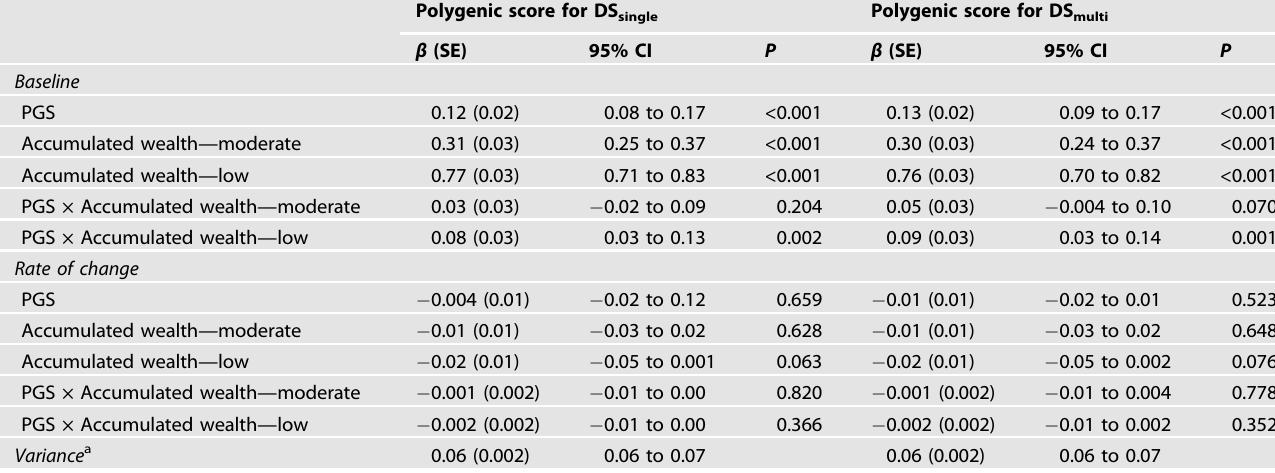
Table 3. Longitudinal mixed models exploring the main effect of polygenic score for DS and accumulated wealth, and interaction between these two variables, in relation to depressive symptoms trajectories during the 14-year follow-up